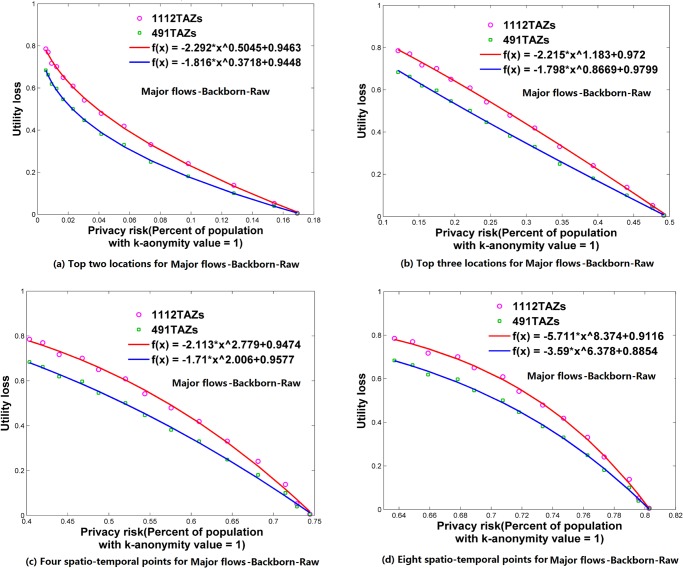
Relationships between privacy risk and data utility using Major flows-Backborn-Raw.(a) Top two locations. (b) Top three locations. (c) Four spatio-temporal points. (d) Eight spatio-temporal points.